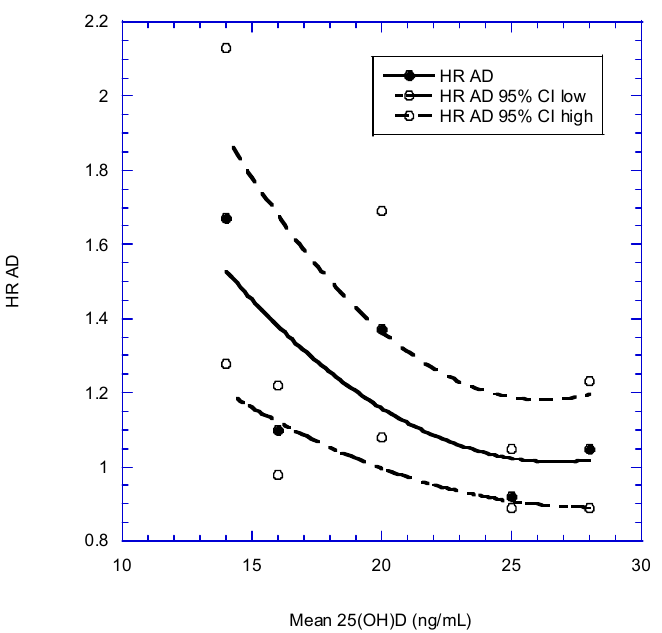
Figure 3. Hazard ratios (HR; mean and 95% confidence interval [CI]) for Alzheimer’s disease (AD) according to mean 25 ‐ hydroxyvitamin D [25(OH)D] concentrations for each of the six studies included in the meta ‐ analysis [138].